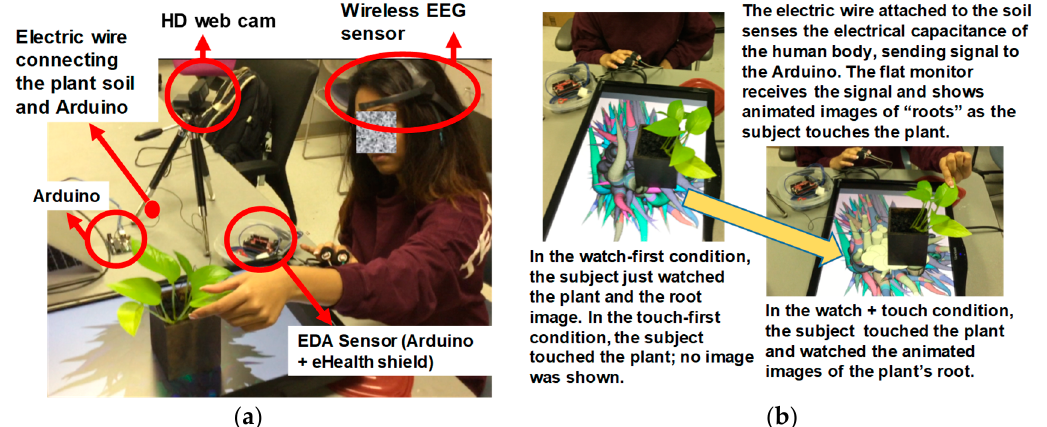
Figure 1. A depiction of the Interactive Plant system. ( a ) The Interactive Plant system consists of a pothos plant sitting on a flat screen, an electric wire and an Arduino microprocessor. The electric wire, which is placed in the soil, catches tactile signals on the plant and sends them to the Arduino microprocessor. Participants’ electrodermal activity and brain wave (EEG) are also measured. ( b ) In the watch ‐ first condition, participants just watched the plant and screen. In the touch ‐ first condition, participants touched the plant. The flat screen was turned off in this condition and participants did not see any animated images of the plant. In the watch + touch condition, participants touched the plant and watched the animated images of the plant on the screen. The image changed real time as participants touched the plant.